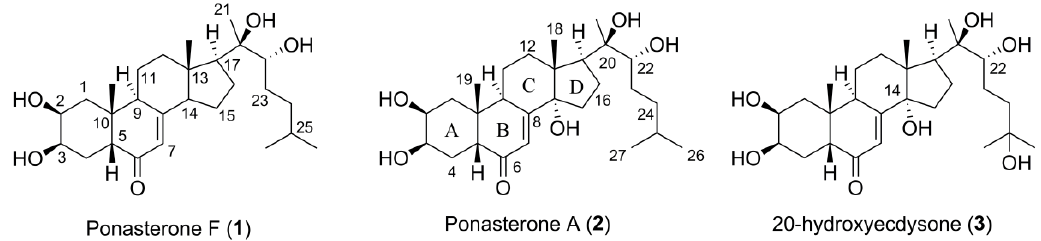
Figure 1. The structures of the herein isolated compounds ponasterone F ( 1 ) and A ( 2 ) and 20-hydroxyecdysone ( 3 ), a similar ecdysteroid reported in literature.